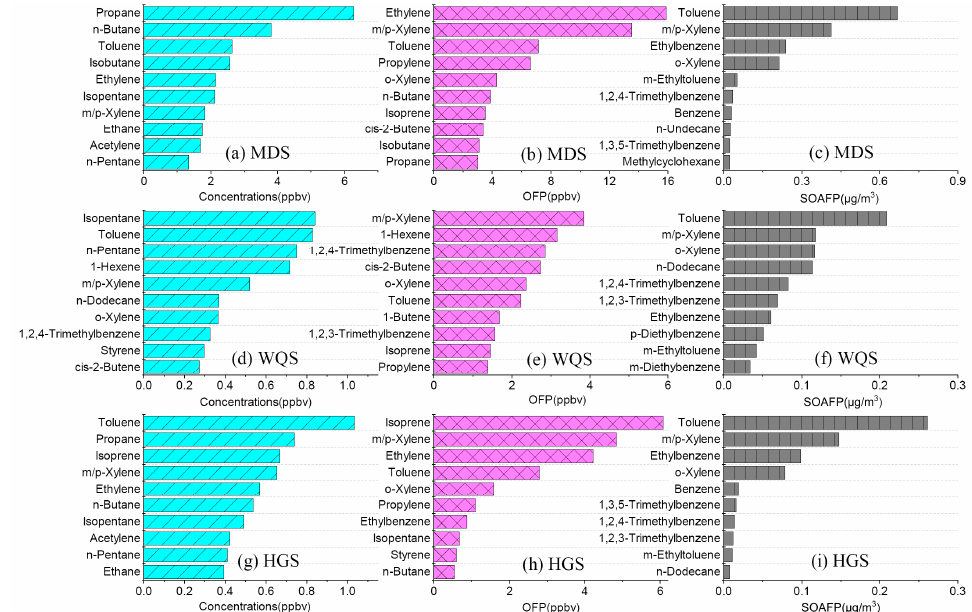
Figure 7. The top 10 VOC species by ( a ) concentrations at MDS, ( b ) ozone formation potentials (OFP) at MDS, ( c ) secondary organic aerosol formation potential (SOAFP) at MDS, ( d ) concentrations at WQS, ( e ) OFP at WQS, ( f ) SOAFP at WQS, ( g ) concentrations at HGS, ( h ) OFP at HGS, and ( i ) SOAFP at HGS.